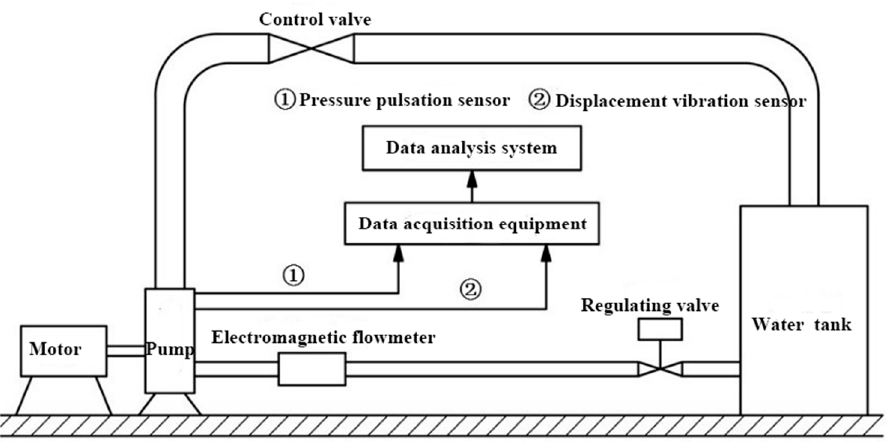
Figure 1. Figure of circulation circuit of the pump. The high-speed centrifugal pump and the position of the sensor are shown in Figure 2. The sensitivity of the pressure fluctuations sensor was 1000 MV/MPa, and the measuring range was 0–5 MPa. The vibration sensor was an eddy current displacement sensor. Three circumferential uniform pressure fluctuations sensors were installed in the flow field of the impeller and the guide vane, and three circumferential sensors were installed in the trailing edge of the inducer.